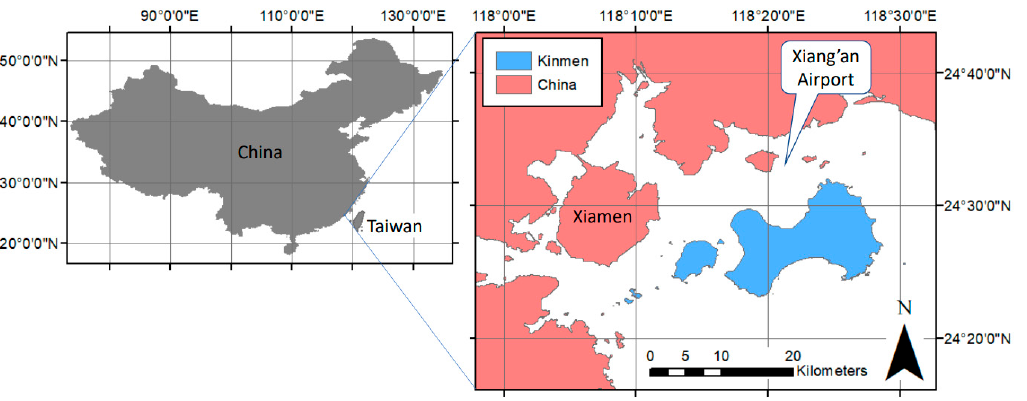
Figure 1. The geographical location of Kinmen with the location of Xiang’an Airport before reclamation of the land.